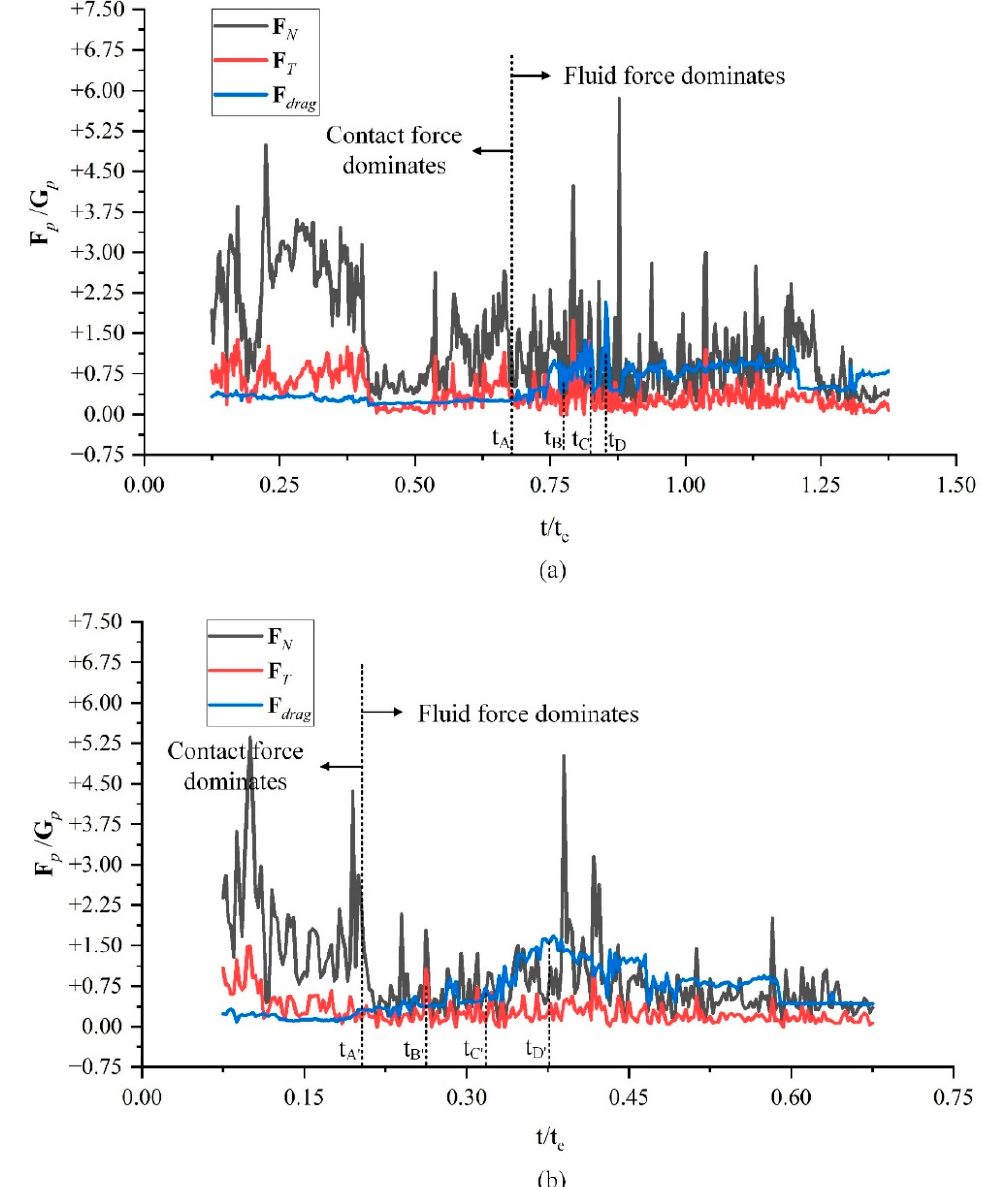
Figure 20. Comparison of contact forces and interphase drag between particles: ( a ) particle 1 and ( b ) particle 2.